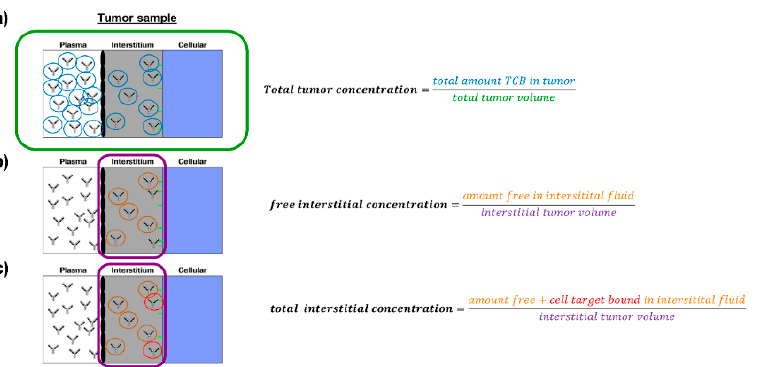
Figure 1. Schematic definitions of tumour-focused PK readouts: ( a ) Total tumour concentration (TTC), which relates the total amount of antibodies to the total tumour tissue sample volume, with no distinction of plasma, interstitial or cellular compartment, ( b ) free interstitial concentration (FIC), which represents what is directly measured by the centrifugation method, i.e., free antibodies specifically in the interstitial fluid space, ( c ) total interstitial concentration (TIC), which accounts for free and cell surface target-bound antibodies specifically in the interstitial fluid space.